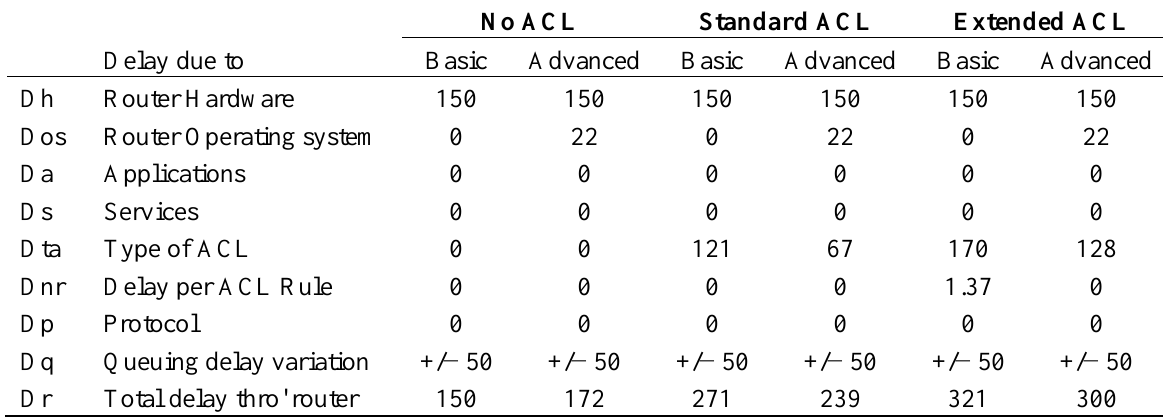
Table 3. Calculating parameters from tests performed (times in µs).